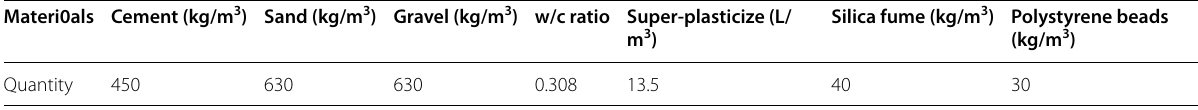
Table 3 Mix proportion of concrete.